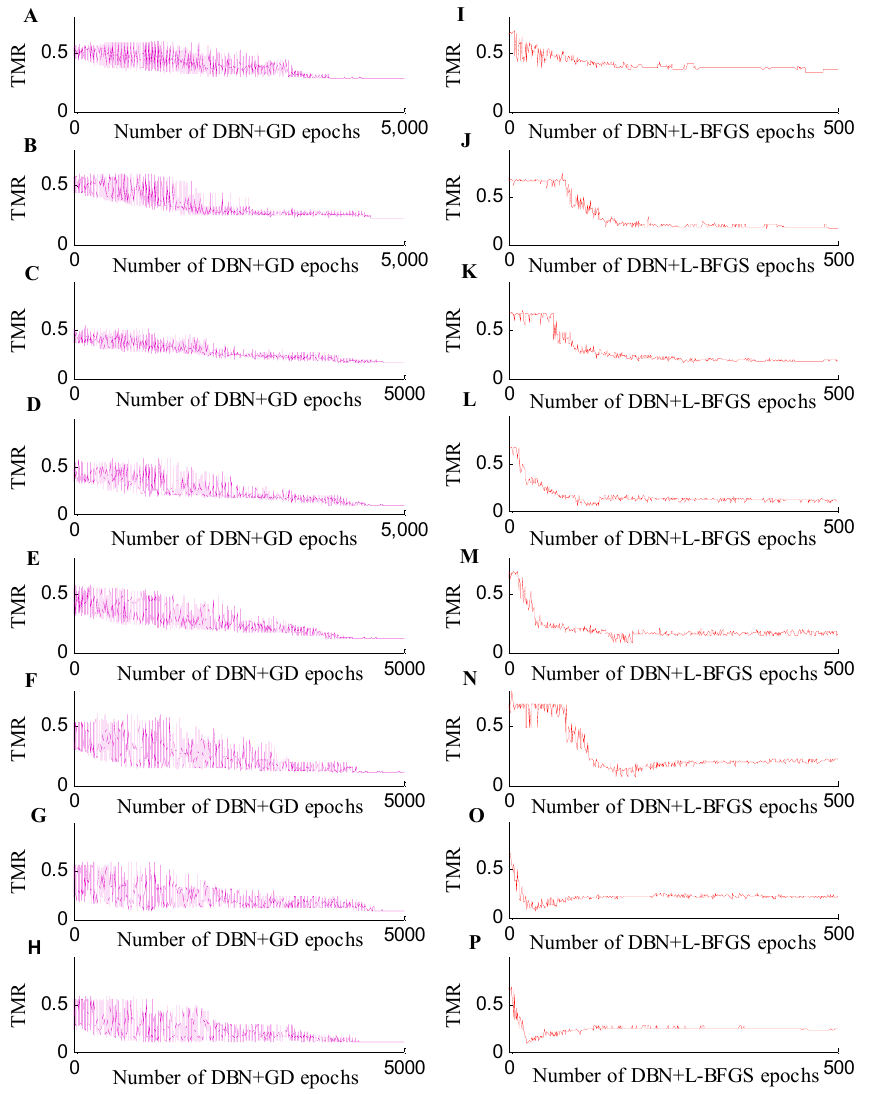
Figure 3. Misclassification rate curve from the 50 to 120 training sets. ( A – H ) are the training misclassification rate (TMR) curves of DBN + GD + Softmax for the number of training sets from 50 to 120, and ( I – P ) are the TMR curves of DBN + L-BFGS + Softmax for the number of training sets from 50 to 120.